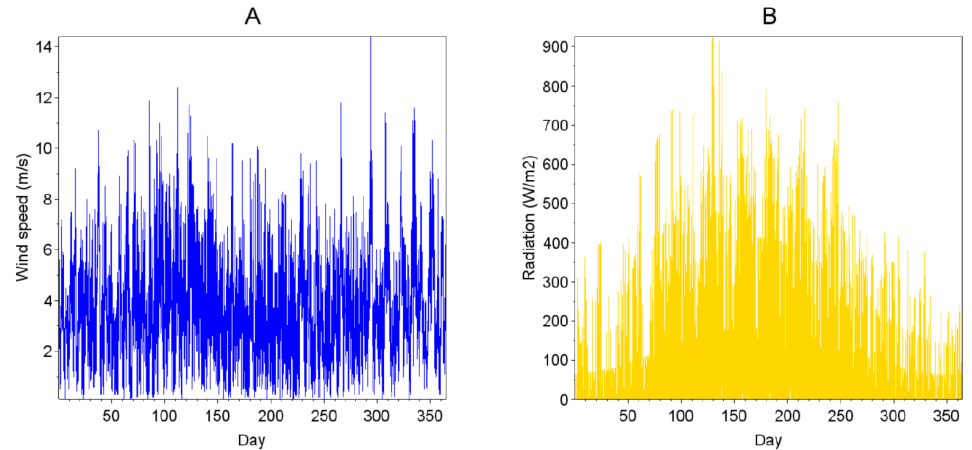
Figure 2. Annual distribution: ( A ) wind speed, and ( B ) solar radiation.